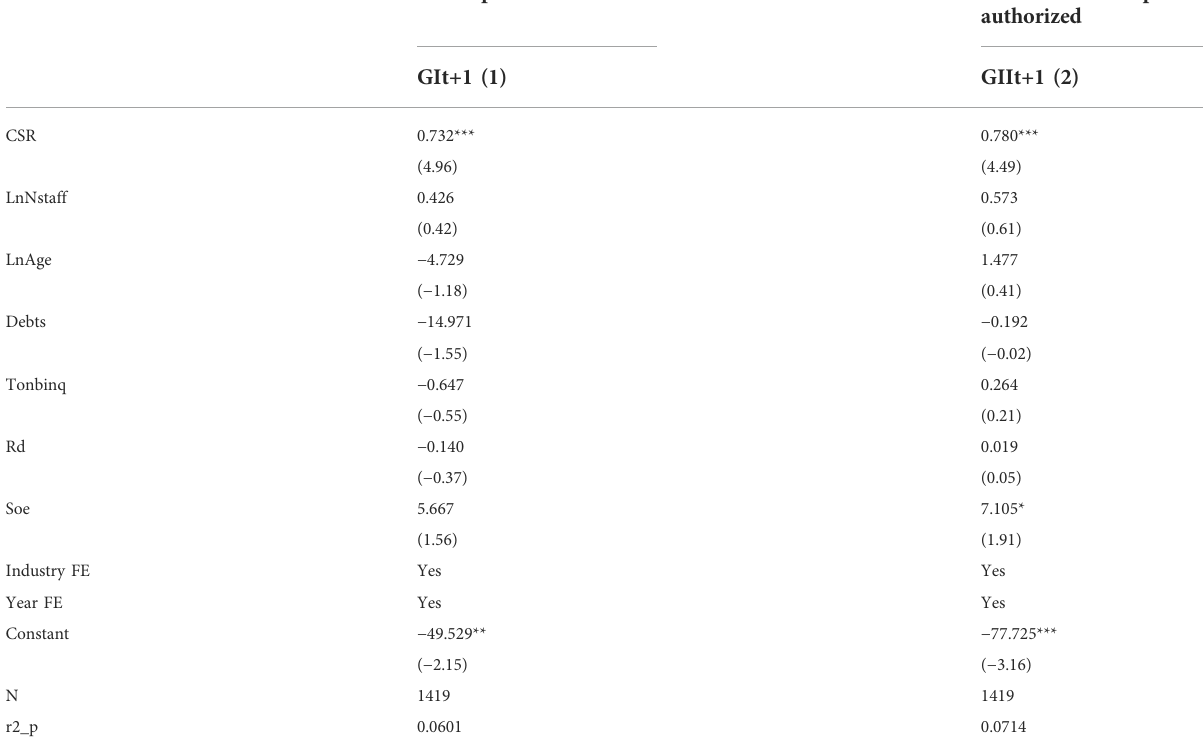
TABLE 4 CSR performance and green innovation